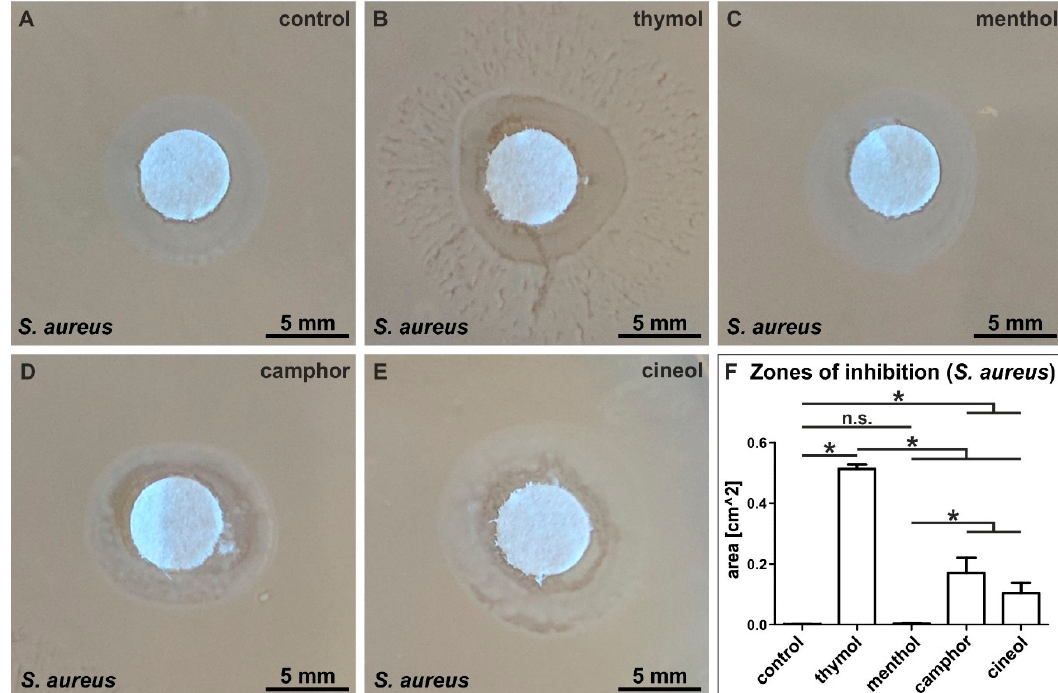
Figure 7. Invasomes encapsulating thymol, camphor and cineol show bactericidal activity against S. aureus in a growth-inhibition zone assay. ( A ) Control invasomes without terpenoids did not affect bacterial growth. ( B ) Strong growth inhibition of S. aureus exposed to invasomes comprising thymol. ( C ) Invasomes encapsulating menthol did not affect growth of S. aureus. ( D – E ) Growth inhibition of S. aureus exposed to invasomes comprising camphor and cineol. ( F ) Statistical evaluation of the measured zones of inhibition validated the significant inhibition of S. aureus growth by